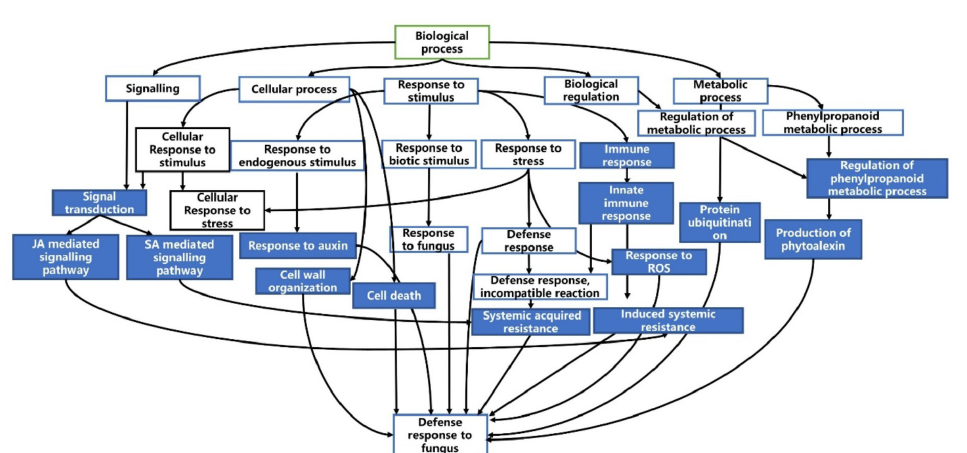
Fig. 7. Directed acyclic graph for biological processes related to defence in